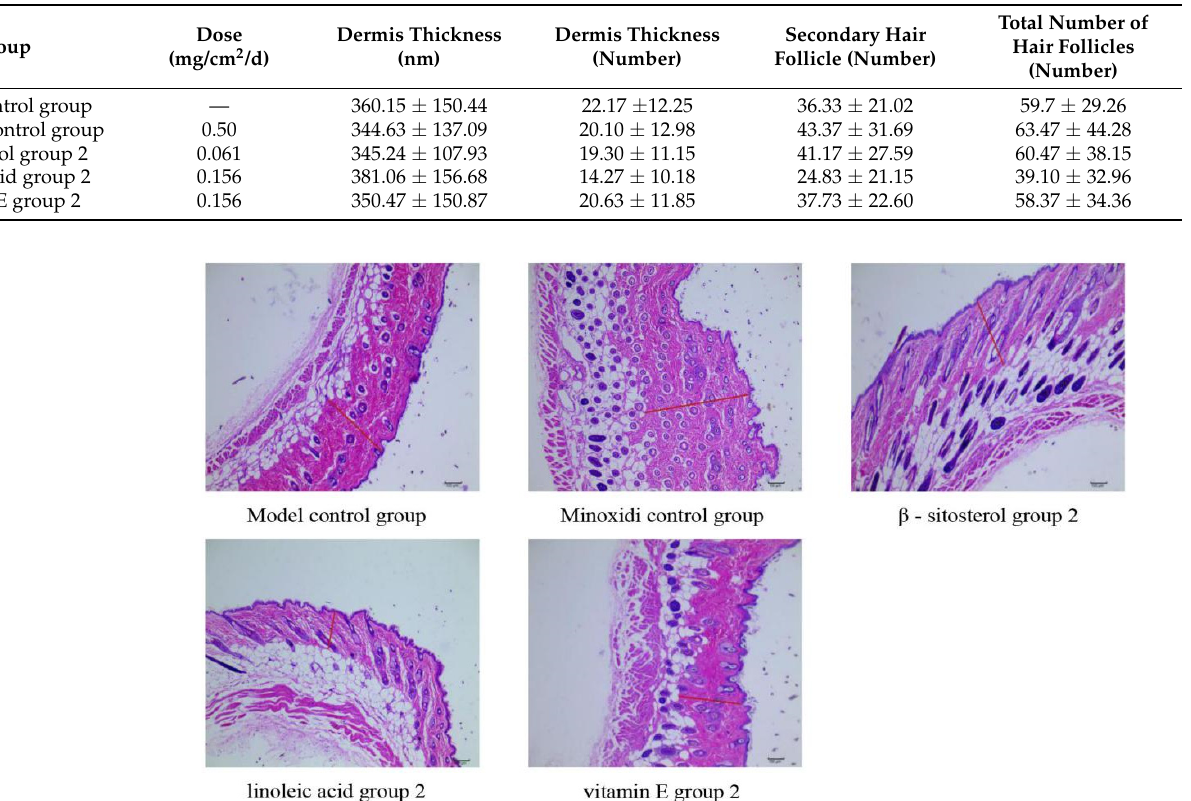
Table 16. Effects of three effective components of the kernel of P. mira on the number of hair follicles and dermal thickness in the experiment of C57BL/6 mice depilation model induced by sodium sulfide.